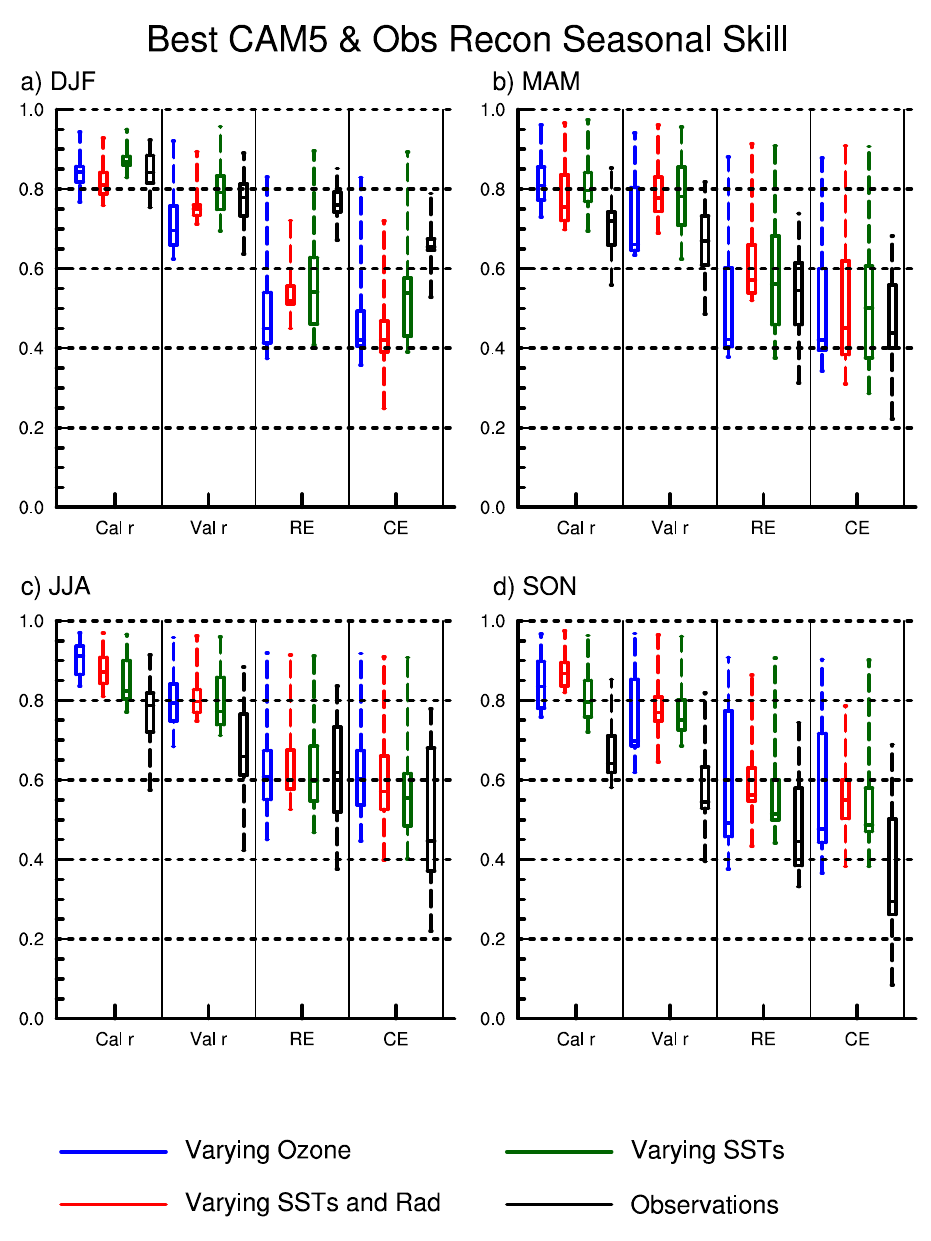
Figure 2. Best CAM5 seasonal reconstruction skill metrics across 5%, 10%, original and detrended networks and all ensemble members within each experiment for ( a ) DJF ( b ) MAM ( c ) JJA and ( d ) SON. Best observation-based reconstruction values from [28] are also added in black. See text for additional details on how these skill metrics were calculated for each dataset.